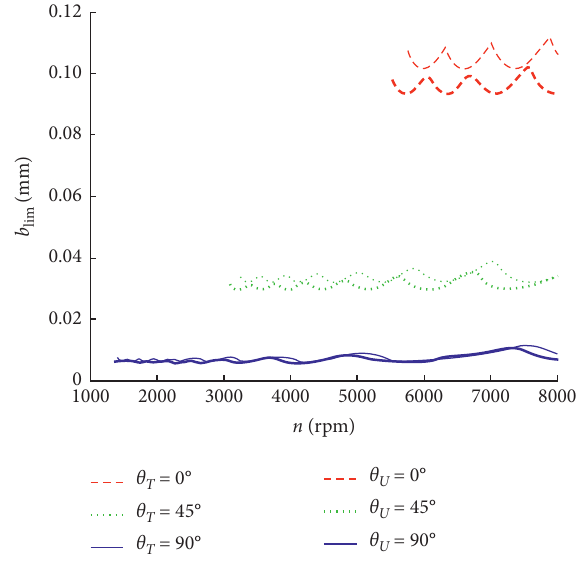
Figure 9: Effect of the ply angle on chatter